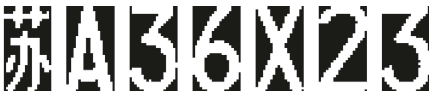
Figure 9: Character segmentation